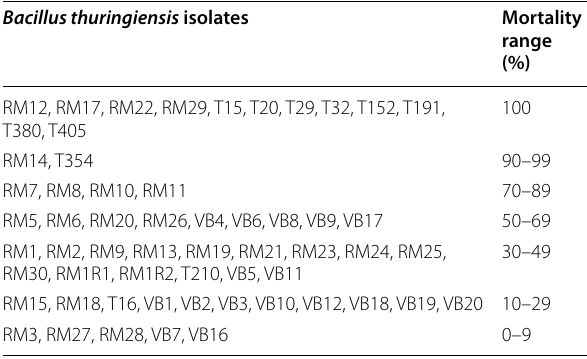
Table 5 Grouping of Bt isolates based on mortality of Plutella xylostella larvae at 25 µg/ml Bacillus thuringiensis